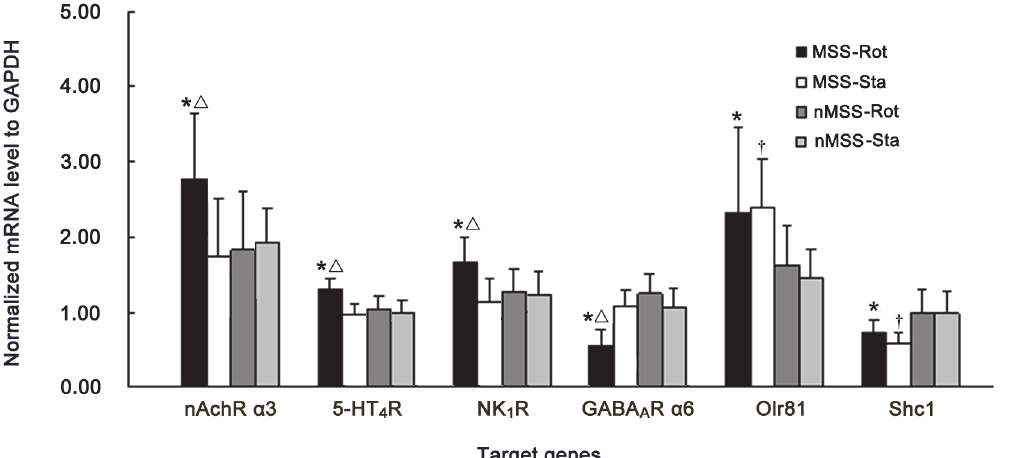
Fig 4. RT-qPCR verification of candidate genes mRNA levels, including the nAchR α 3 subunit, 5-HT 4 R, NK 1 R, the GABA A R α 6 subunit, Olr81 and Shc1 in the CVN of MSS and inMSS rats receiving 2 hours of rotation or static treatment. Values in each group (n = 6) are expressed as the percentage of their corresponding GAPDH values (100%) and shown as the means ( ± S.E.). * P < 0.05, compared with inMSS-Rot group; Δ P < 0.05, compared with MSS-Sta group; † P < 0.05 compared with inMSS-Sta